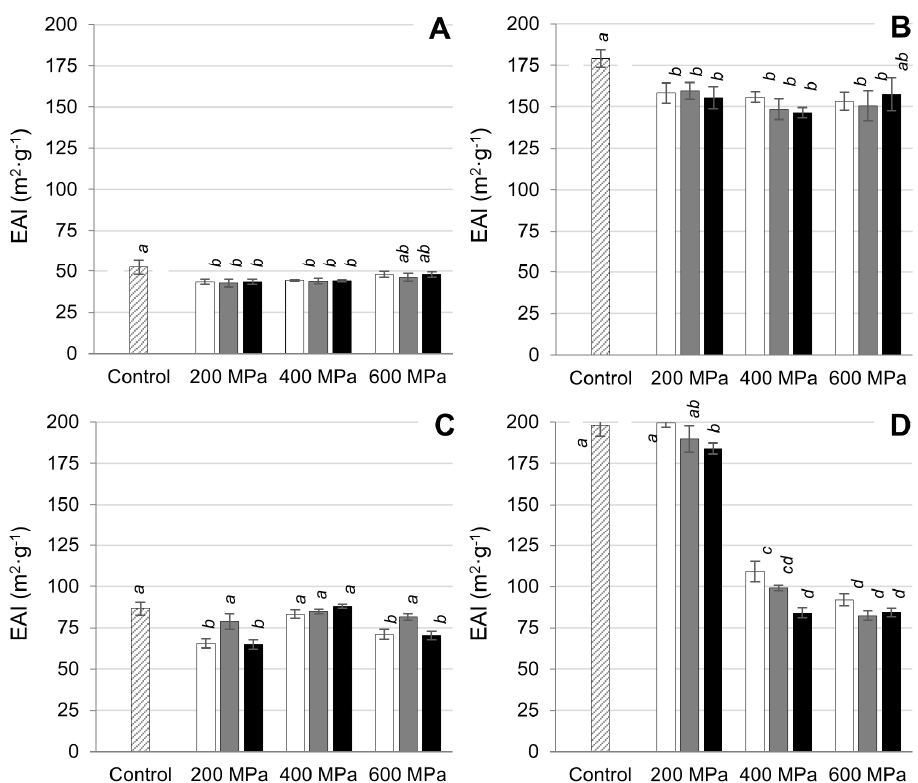
Figure 4. Emulsifying activity index (EAI) measured for O/W emulsions prepared with pea (( A )— total fraction, ( B )—soluble fraction) and soy (( C )—total fraction, ( D )—soluble fraction) protein dispersions (pH 8), previously subjected to different high-pressure processing treatments (200, 400 and 600 MPa for 5, 10 and 15 min). The columns with diagonal stripes represent unprocessed (0.1 MPa) control samples. Blank, gray and black filled columns denote 5-, 10- and 15-min processing times, respectively. Different letters indicate significant differences ( p < 0.05) between samples represented in each